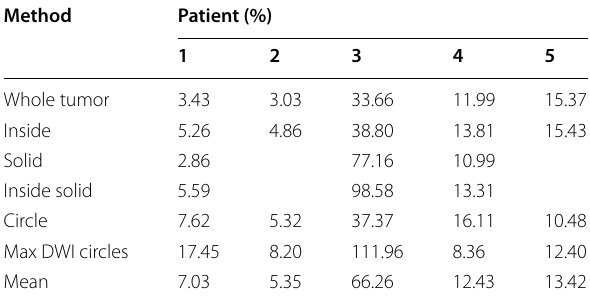
Table 4 Percentage difference of mean ADC when measuring with the same strategy on a slice two steps down in the caudal direction. The measured mean ADC can drastically vary between nearby slices if the tumor is heterogeneous. No measurements were done with the solid strategy on patients 2 and 5, as these did not have any necrotic, cystic, or hemorrhagic components. All methods yield significantly different distributions as determined by the two-sample Kolmogorov–Smirnov